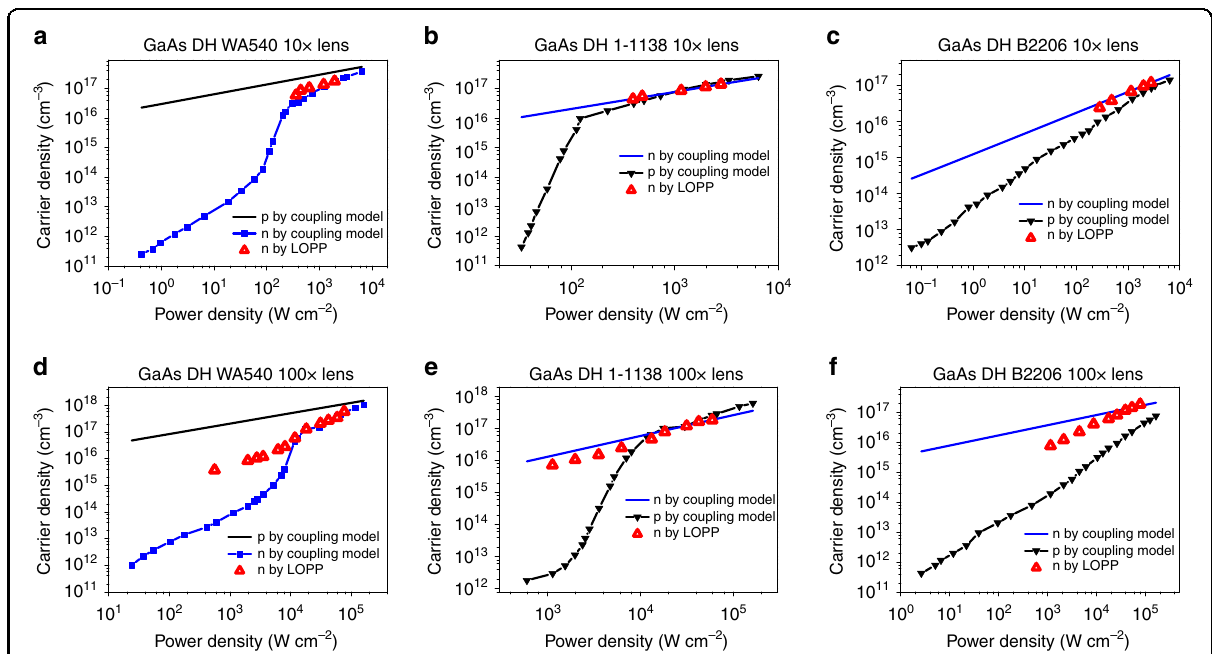
Fig. 4 Derived photo-excited carrier densities with PL and Raman: coupling model (black for holes and blue for electrons) and LOPP (red). a WA540 under 10× lens; b 1-1138 under 10× lens; c B2206 under 10× lens; d WA540 under 100× lens; e 1-1138 under 100× lens; f B2206 under 100×